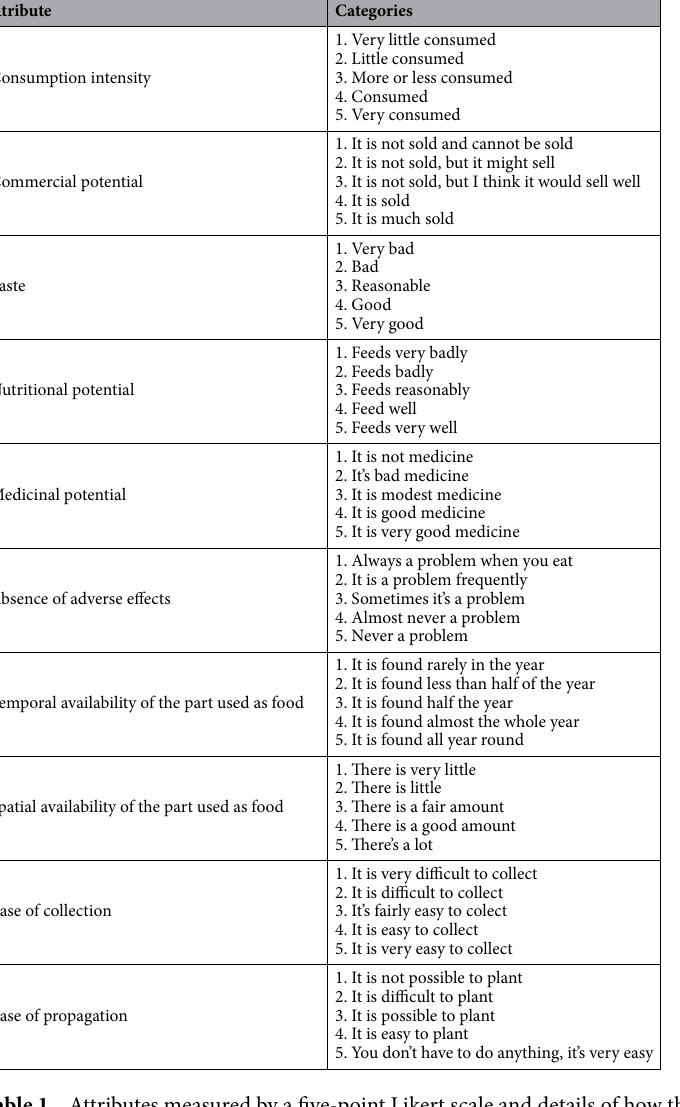
Table 1. Attributes measured by a five-point Likert scale and details of how the scale was presented to respondents from the Dom Helder Câmara rural settlement, Murici municipality, state of Alagoas, Northeast